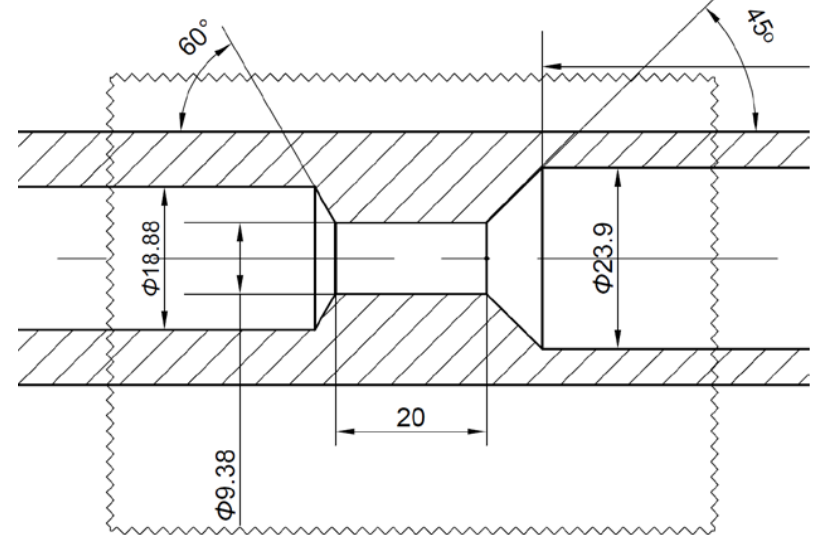
Figure 2. Details of the